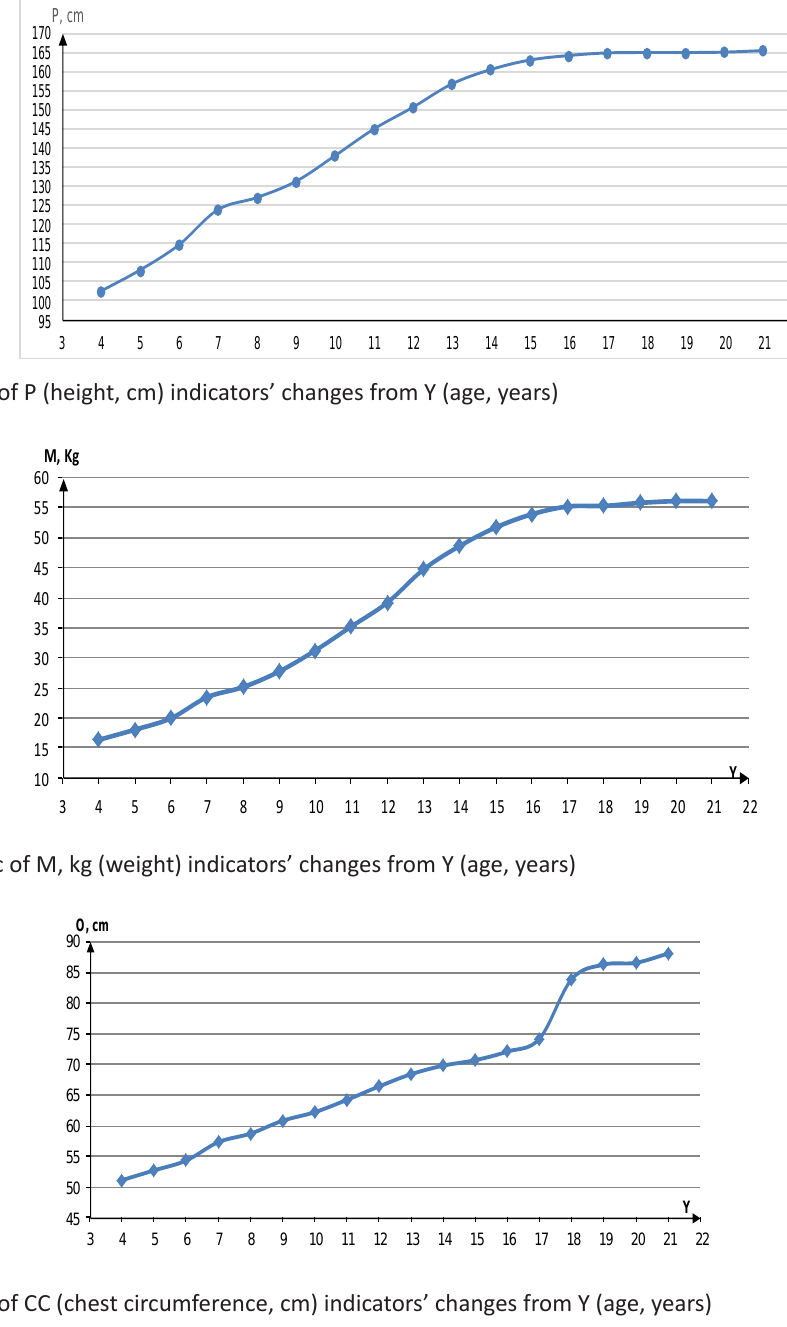
Fig. 3. Dynamic of CC (chest circumference, cm) indicators’ changes from Y (age,